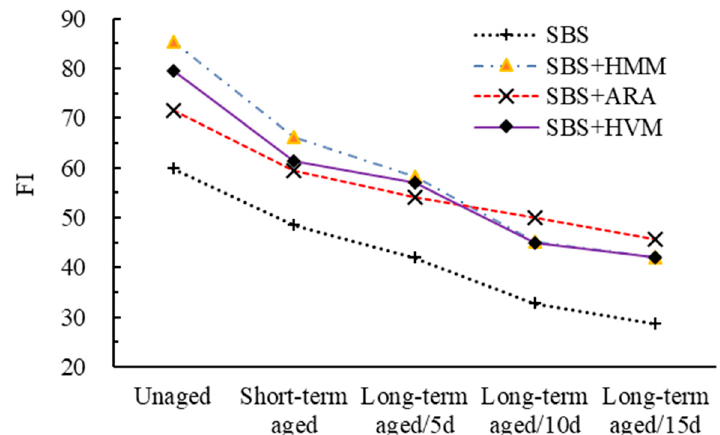
Figure 8. SCB results.